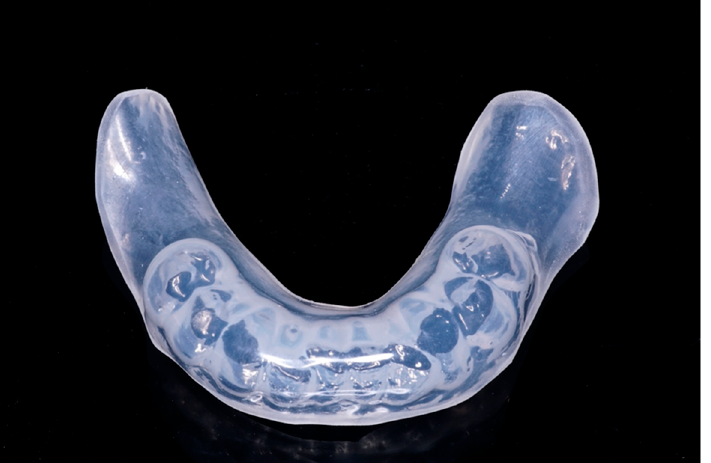
Figure 2. Example of a dental splint that patients in the active control group received in pairs for the upper and lower jaw. In this case, the 5 mm thick thermoplastic splint covers the residual mandibular dentition from tooth 35 to 45.